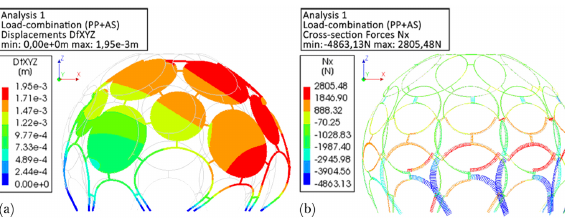
Figure 16: Self-weight and seismic acceleration (Case 2): (a) Dis- placement diagram; (b) Normal stress (Nx) diagram